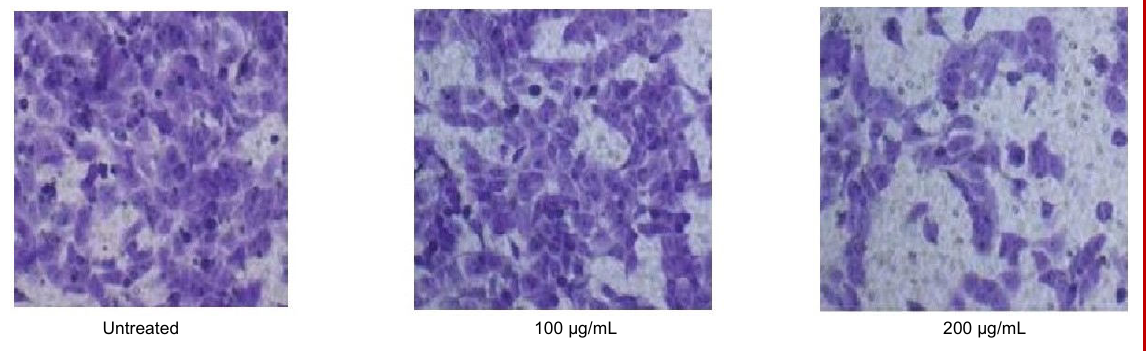
Figure 2: Images of U-2 osteosarcoma cells after 24 hours of untreated cells and treatment with extract of 100 and 200 µg/mL. Im- ages of cells were taken with inverted microscope in bright field at 400x magnification (Olympus,